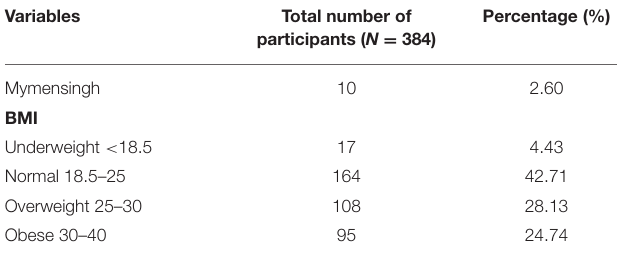
TABLE 1 | Socio-demographic and lifestyle characteristics of variables of the respondents, ( N =